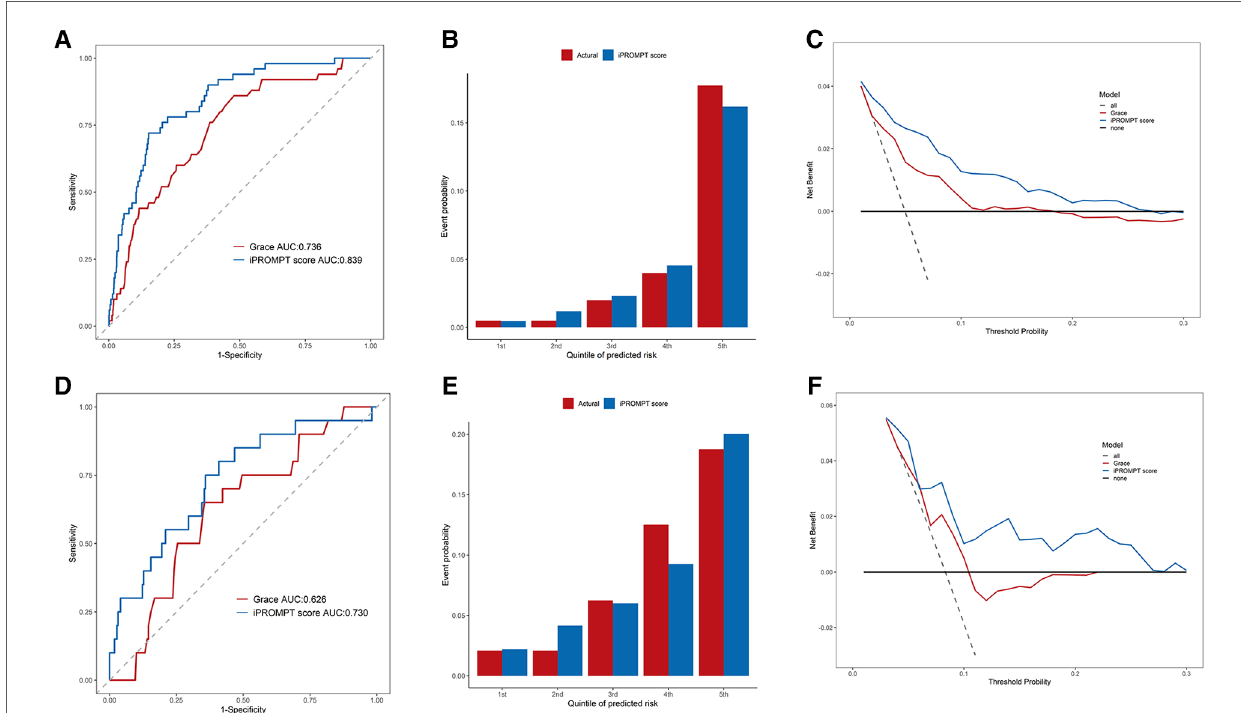
FIGURE 2 Performance evaluation of iPROMPT score and GRACE score in derivation cohort and external validation cohort. ( A,D ) Receiver-operating characteristic curve analysis. The accuracy for MACEs between the iPROMPT score and the GRACE risk score in the in derivation cohort ( A ) and external validation cohort ( D ). ( B,E ) The calibration plot shows the relationship between the observed and predicted proportion of events, grouped by quintile of risk in the in derivation cohort ( B ) and external validation cohort ( E ). ( C,F ) DCA curves for validating the clinical utility of the iPROMPT score and the previous model. AUC, area under the curve; GRACE, the Global Registry of Acute Coronary Events risk score; MACEs, major adverse cardiovascular events; DCA, decision curve